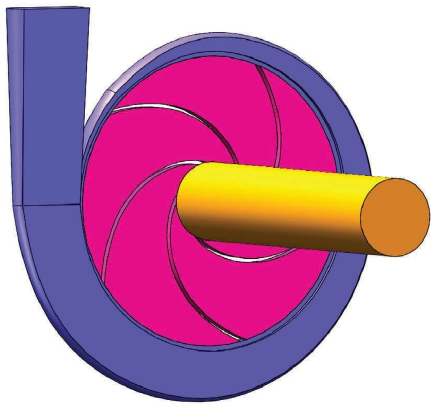
Figure 1: Flow feld diagram.